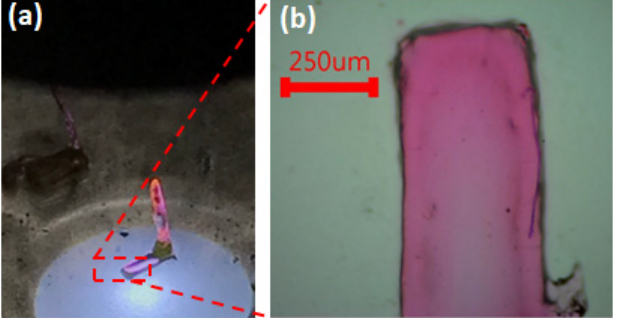
Figure 8. NIR-green light UC assisted laser cross-linking at the focal point: ( a ) photograph; ( b ) optical microscope image the top-down view of the sample.